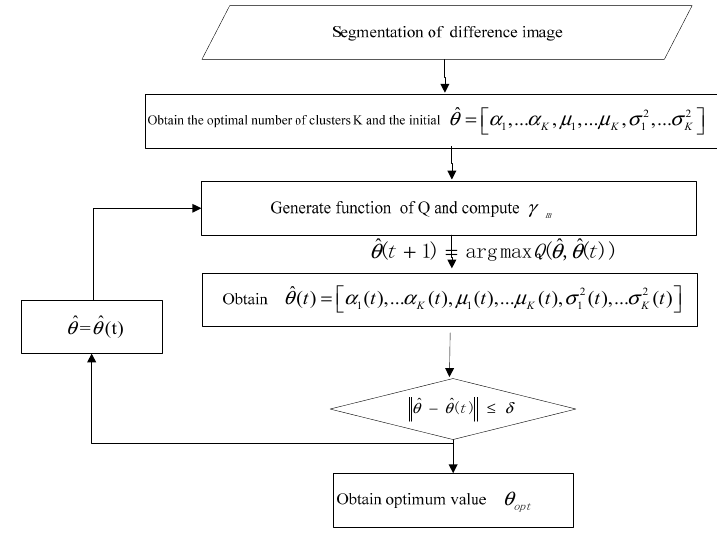
Figure 2. The procedure of the GMM and EM algorithms.